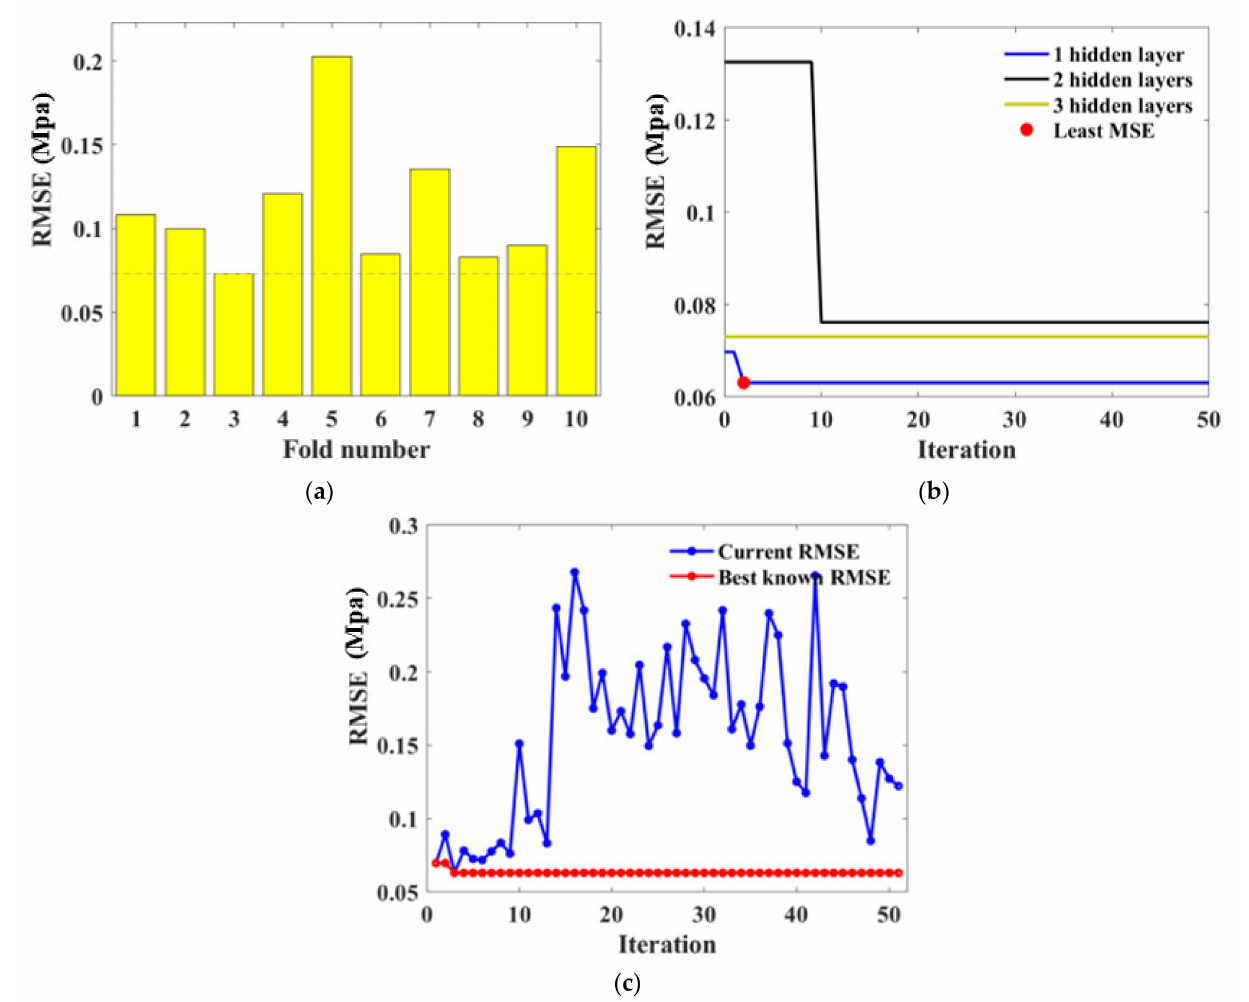
Figure 19. Hyperparameter tuning for BPNN: ( a ) RSME values obtained in 10 validation folds; ( b ) RSME convergency with various numbers of hidden layers; ( c ) Iteration conducted at the 3rd